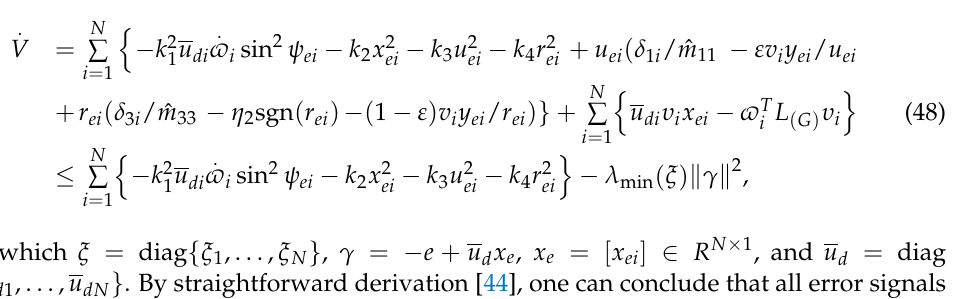
Table 1. Model parameters of WL-II. Para.